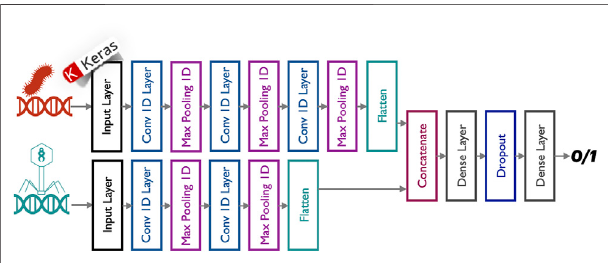
FIGURE 2 | Phage – bacterium interaction predictor (Ataee, Rodriguez, Brochet, & Pena, 2020). The predictor model is composed of a stack of 1-D CNNs. The predictor architecture has a non-linear network topology. The two inputs (bacteria genome sequences and phages genome sequences) are processed separately by two parallel convolutional branches whose outputs are then merged and passed through two sub-sequential dense layers. A dropout layer is also used to reduce over fi tting and to improve the generalization of the proposed deep neural